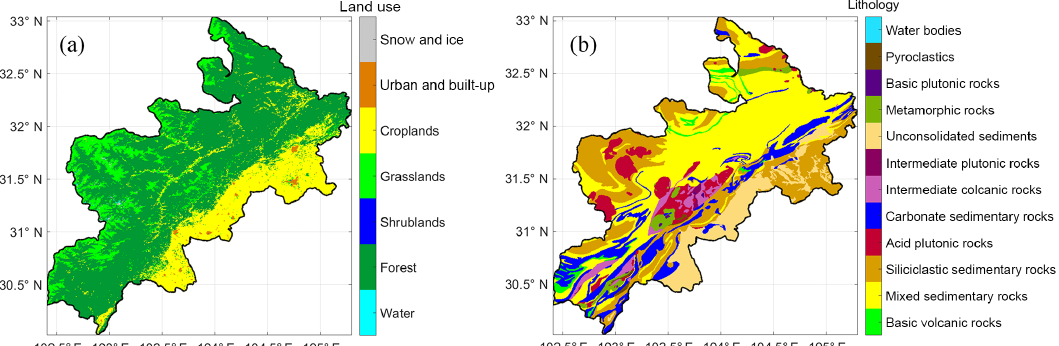
Figure 2. Land use map (a) and lithology map (b) for the study area.